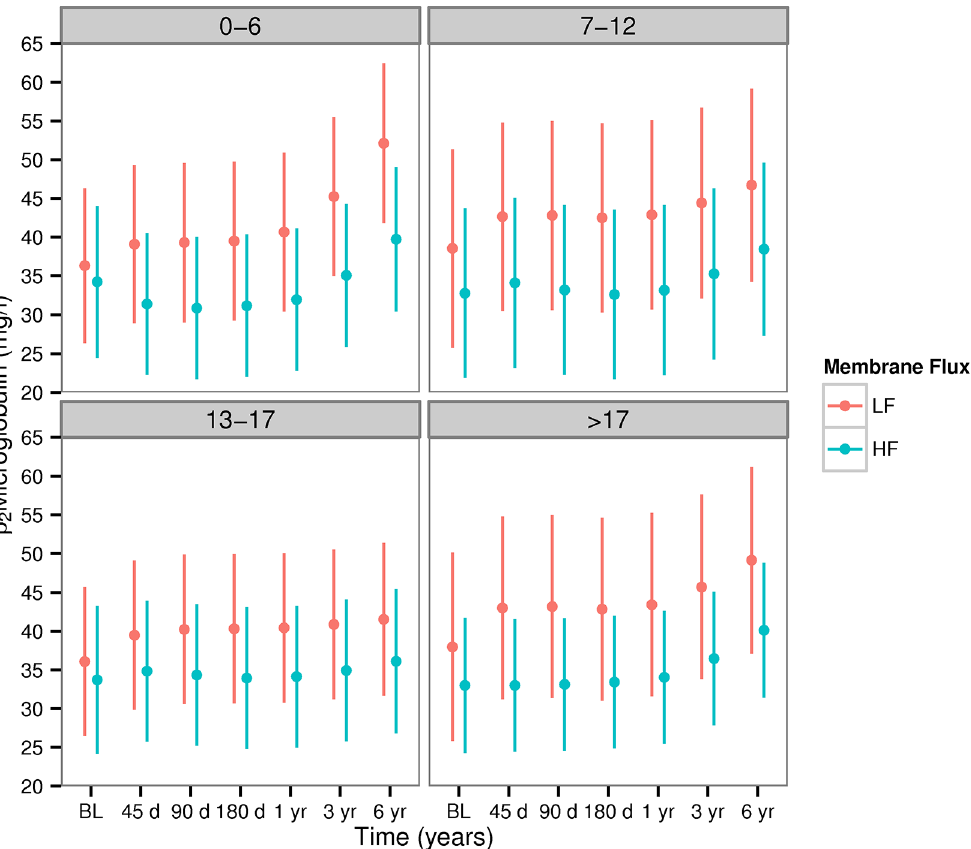
Fig 3. Predicted predialysis β 2M concentrations across reuse quartiles and membrane flux in HEMO participants. These predictions were obtained by fitting a Joint Model to the HEMO dataset which was then used to predict the β 2M concentration for the HEMO study participants at different time points. The panels show the mean and standard deviation obtained by averaging individual level predictions at each time point. Separation between the high (HF) and the low flux(LF) arms in terms of the β 2M concentration were established early in the trial. There was very little difference in the separation of flux arms across the quartiles of reuse, i.e. estimated difference (SE) in β 2M concentration between HF and LF was -8.27 (0.56), -9.67 (1.22), -6.72 (1.06), and -8.42 (1.26) mg/L in the 1st-4th reuse quartiles respectively.